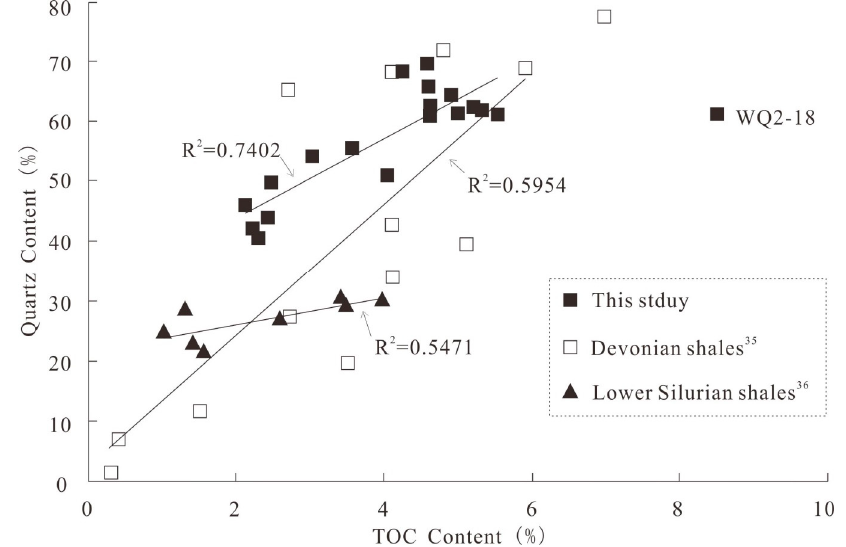
Figure 7. Relationship between the TOC content and quartz content.